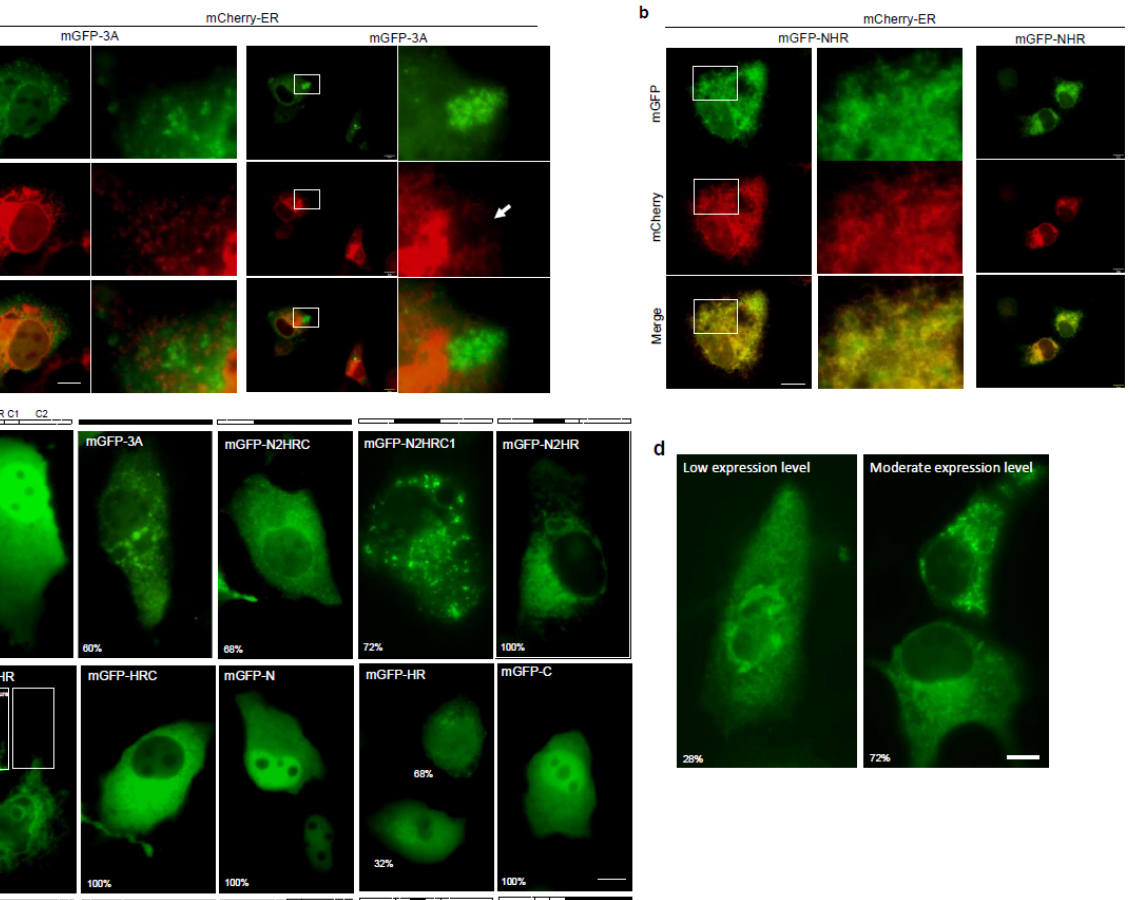
Figure 2. ( a , b ) Images obtained in PK-15 live with mCherry-ER and mGFP-3A (or mGFP-NHR) co-expressed. The white arrow indicates the area of ER fragmentation. ( c ) Images of the variant truncation of 3A, in which the N-terminus was fused to mGFP. The mGFP diffused within the cytoplasm and nucleus. More than half of the cells expressing mGFP-3A, mGFP-N2HRC, and mGFP-N2HRC1 (60%, 68%, and 72%, respectively) showed multiple punctae in the population. In addition, mGFP-N2HR and mGFP-NHR showed reticular patterns, while only 68% of the mGFP-HR-expressing cells were reticular and the others appeared to be diffuse-type. The mGFP-HRC protein distributed diffusely in the cytoplasm, and mGFP-N and mGFP-C in the cytoplasm and nucleus. ( d ) N2HRC1 expression in PK-15 cells showing reticular and punctae patterns at low (with longer exposure time) and moderate expression levels. Scale bar, 10 µ